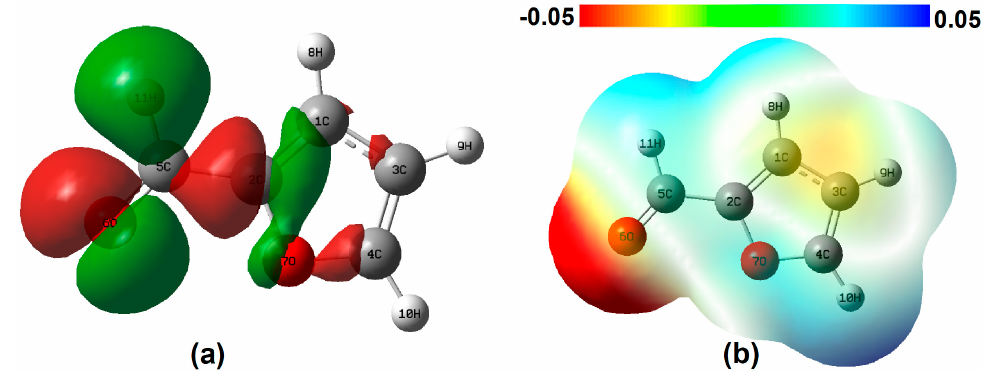
Figure 2. ( a ) Charge difference densities of furfural (the green and red stand for holes and electrons, respectively); ( b ) The static potential distribution of furfural (the red and blue represent low potential and high potential, respectively). Table 1. Raman vibration mode assignments of furfural molecules.